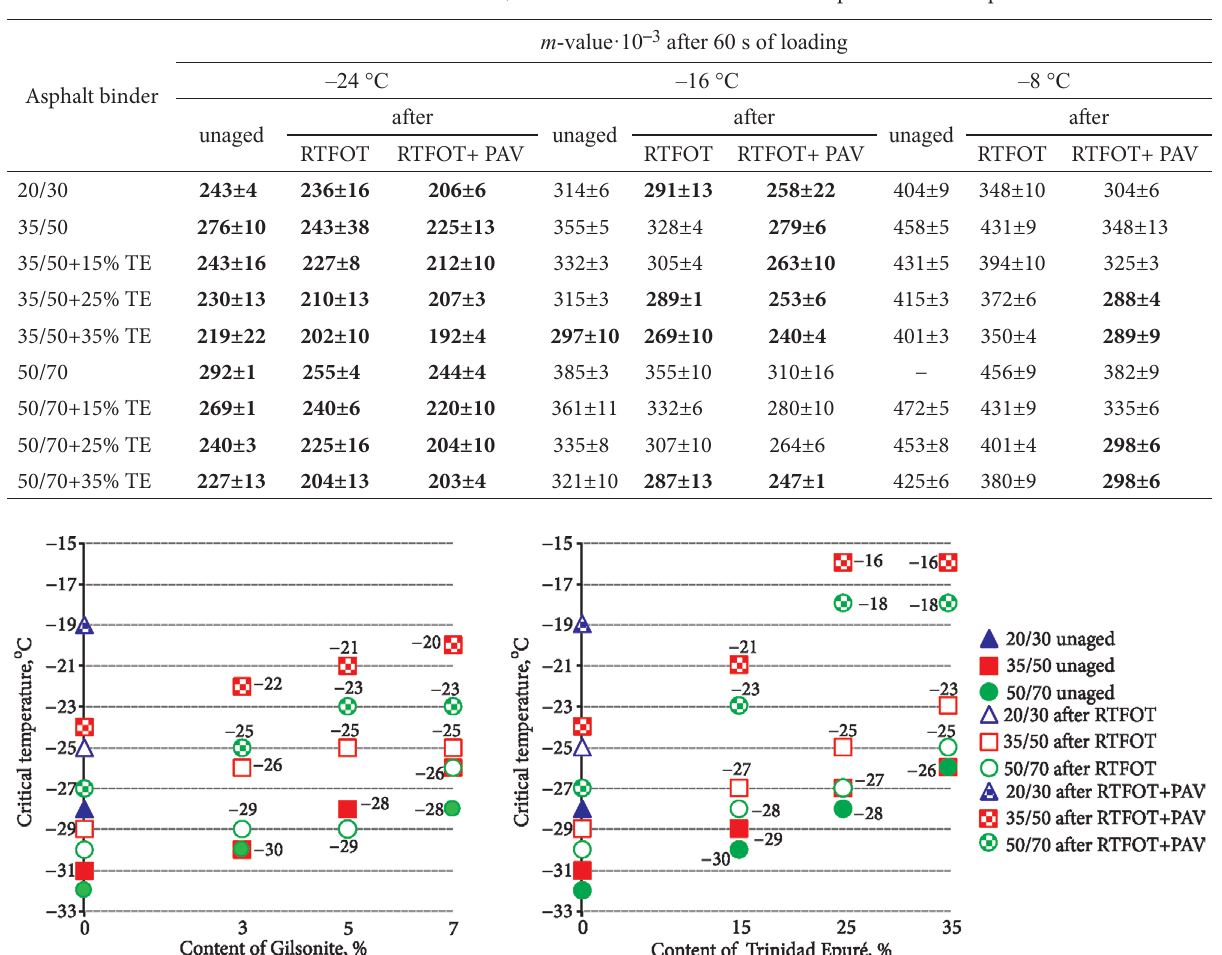
Table 6. Results of the m -value determination at –24 °C, –16 °C and –8 °C for the Trinidad Epuré modified asphalt binders